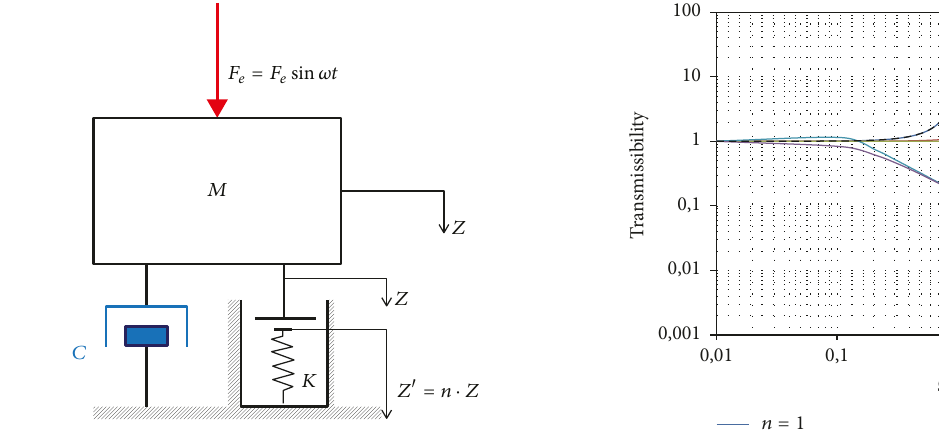
Figure 3: Impedance matching of a spring to a suspended mass trough a 𝑍 -transmitter.